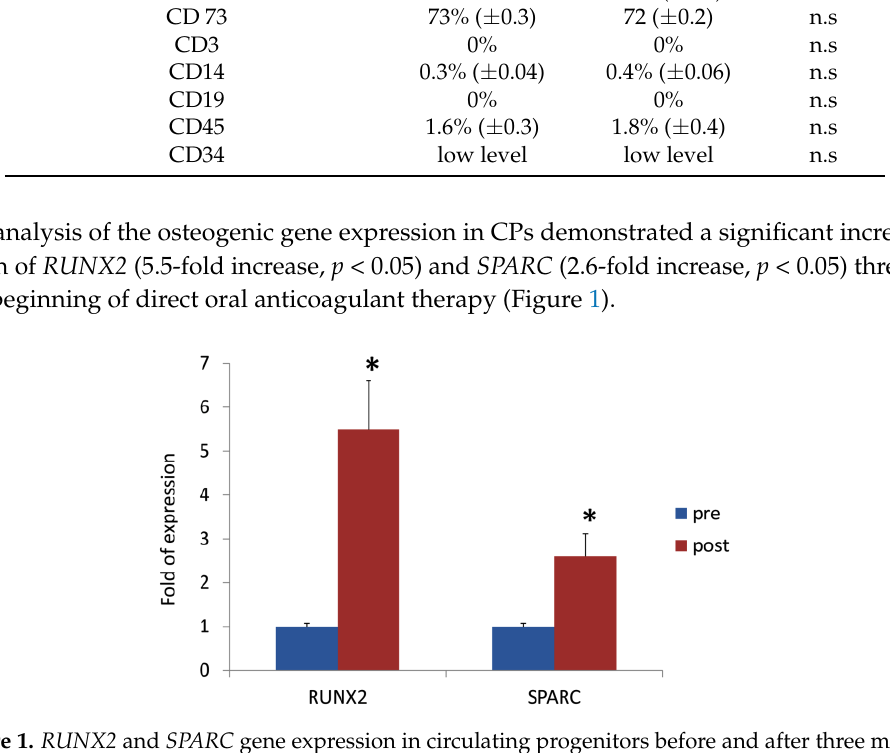
Figure 1. RUNX2 and SPARC gene expression in circulating progenitors before and after three months of DOAC treatment. * p < 0.05.